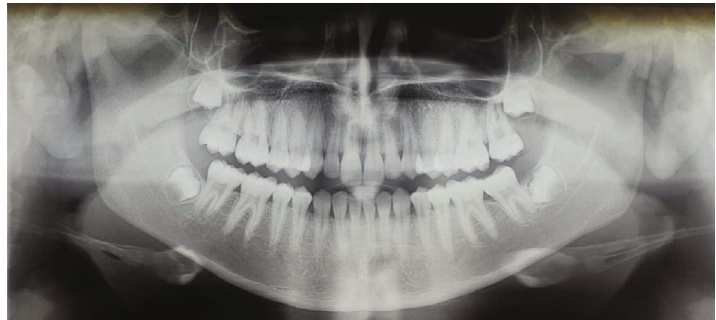
Figure 4: Initial OPT.